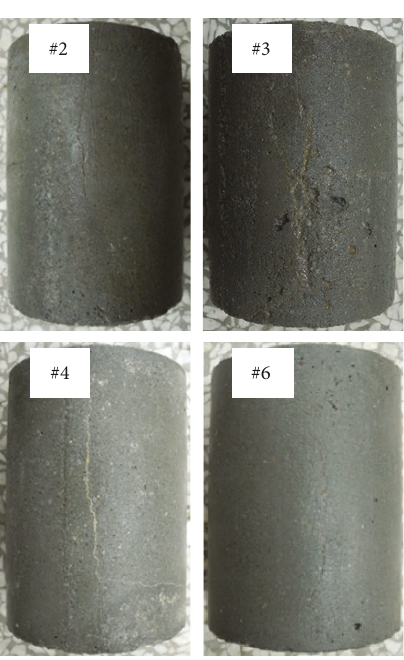
Figure 10: Fractured